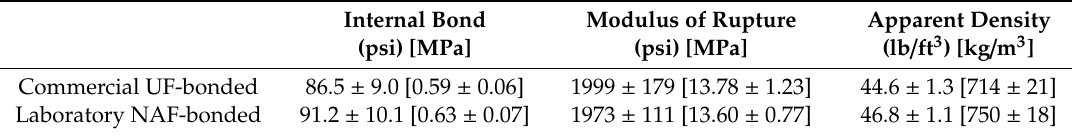
Table 1. Physical properties of commercial and laboratory panels.